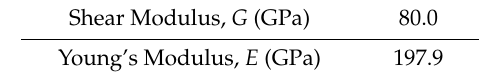
Table 1. Material parameter—A227 hard drawn wire [8].